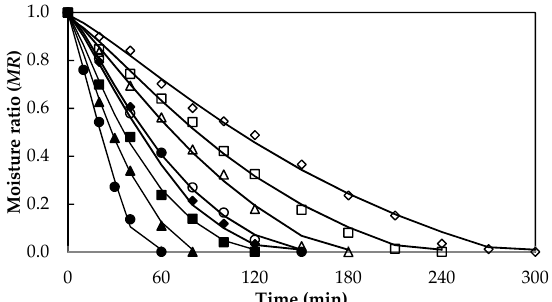
Figure 3. Drying kinetics adjusted by Midilli–Kuck model for Aloe vera gel slabs with 5 mm (60 °C, ♦ ; 70 °C, ■ ; 80 °C, ▲ ; 90 °C, ● ) and 10 mm (60 °C, ◊ ; 70 °C, □ ; 80 °C, ∆ ; 90 °C, ○ ) thickness.